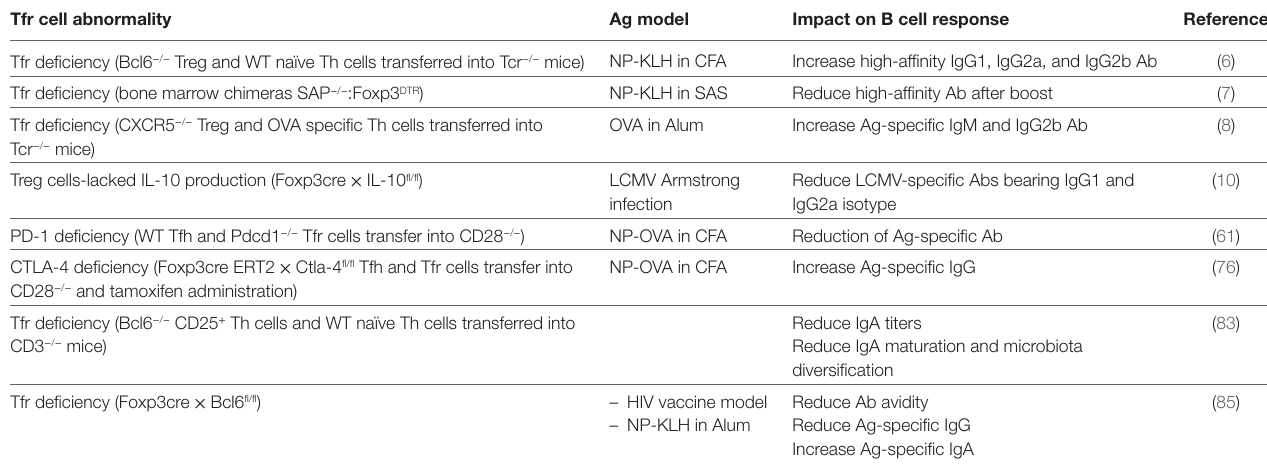
Table 1 | Impact of Tfr cell abnormalities on B cell